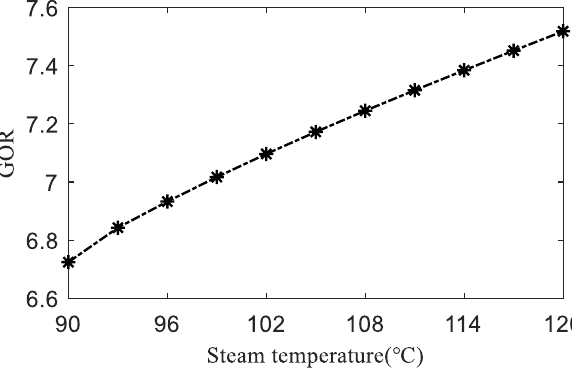
Figure 9. E ff ect of steam temperature ( T steam ) on distillate flowrate ( W DN ). Figure 9. Effect of steam temperature ( steam T ) on distillate flowrate ( DN W ).